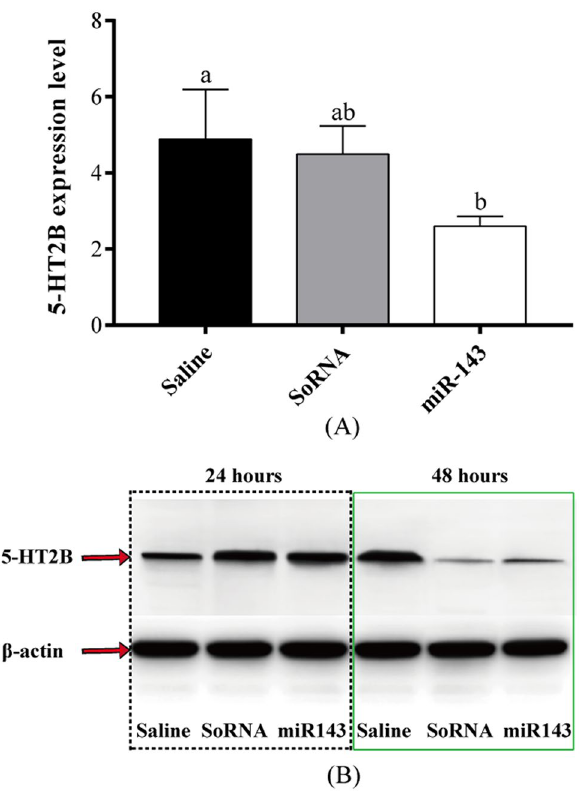
Figure 6. ( A ) 5-HT2B mRNA level after 48 h of miR-143 injection; ( B ) Relative expression levels of 5-HT2B protein 48 h after miR-143 injection as revealed using Western blot. The black dotted box indicates 5-HT2B protein level 24 h after injection and the green solid box indicates 5-HT2B protein level after 48 h. Different letters above the horizontal line indicate significant differences between the miR-143 injection and saline injection groups ( P <